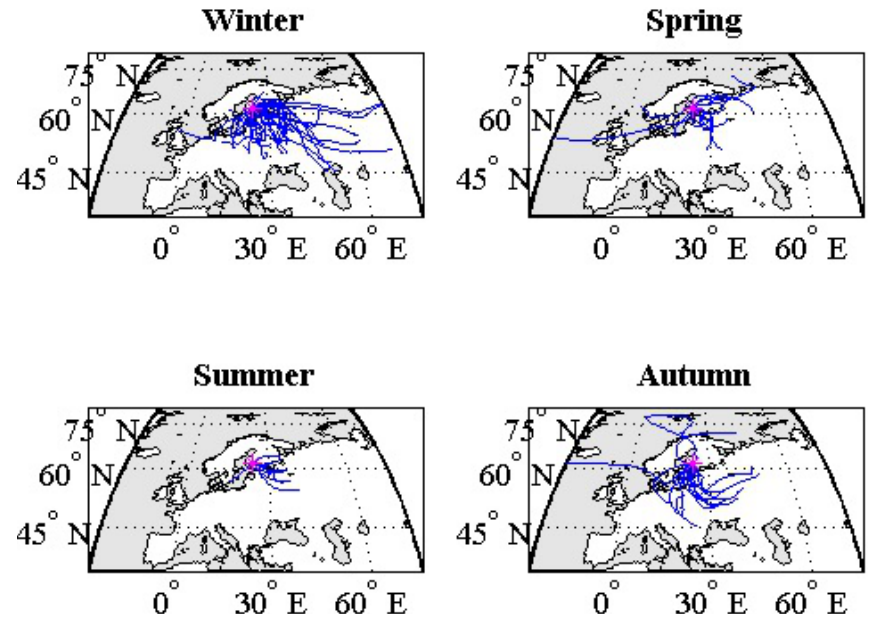
Fig. 14. Seasonal 4-day air mass back trajectories arriving at Hyyti¨al¨a (2005) for the samples where REMO-HAM is overestimating the measurements.